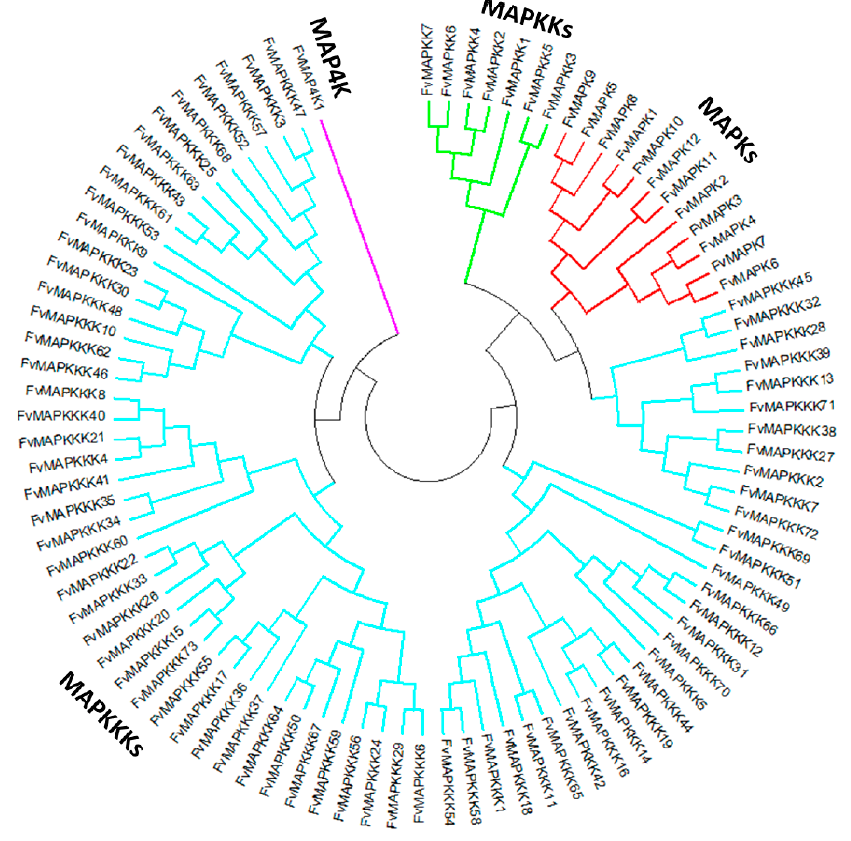
Figure 2. Phylogenetic relationships between strawberry MAPK cascade proteins. The abbreviations of MAPK cascade proteins are as follows: MAPK, Mitogen-activated Protein Kinase, red lines; MAPKK, MAPK Kinase, green lines; MAPKKK, MAPKK Kinase, blue lines; MAP4K, MAPKKK Kinase, purple lines.